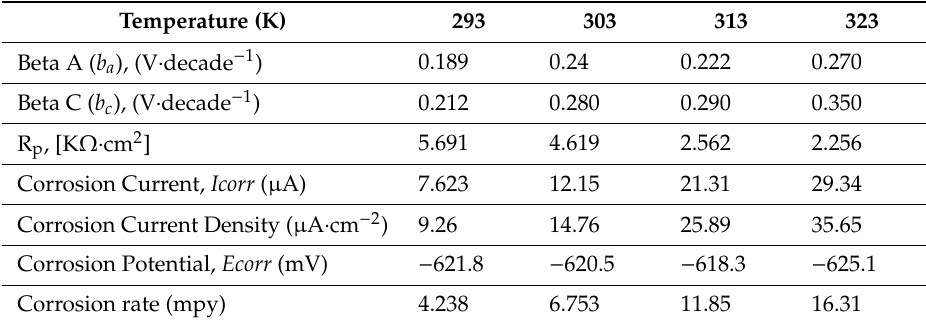
Table 5. Potentiodynamic polarization parameters for API-X120 steel in GTL process water at di ff erent